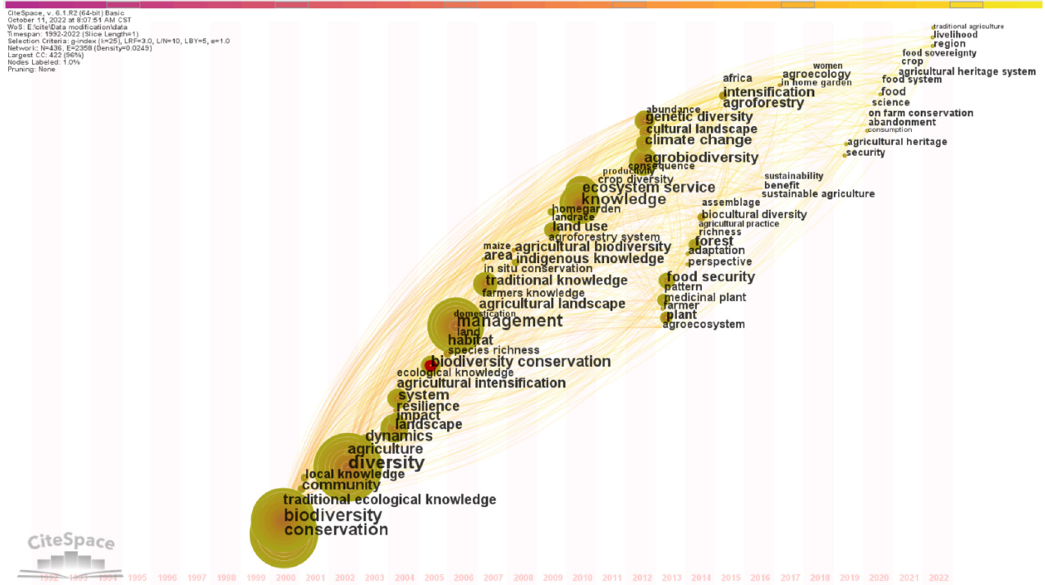
Figure 8. The keywords time-zone view of the agrobiodiversity and traditional knowledge from 1992 to mid-2022.